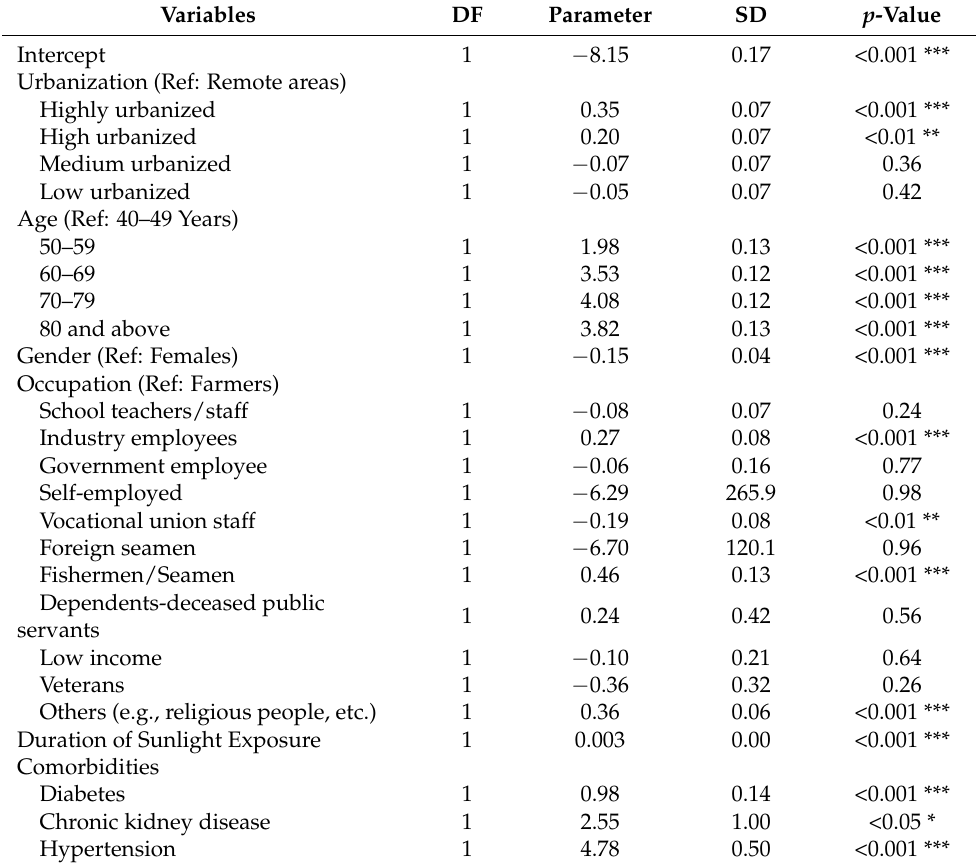
Table 3. Results of Logistic Regression (N = 396,321).